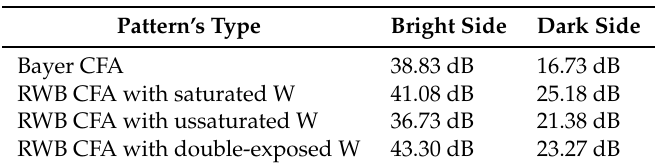
Figure 15. Comparison of HDR reconstruction results: ( a ) Bayer CFA; ( b ) RWB CFA with saturated W; ( c ) RWB CFA with unsaturated W; and ( d ) double-exposed RWB CFA. Table 3. SNR comparison of HDR reconstructed